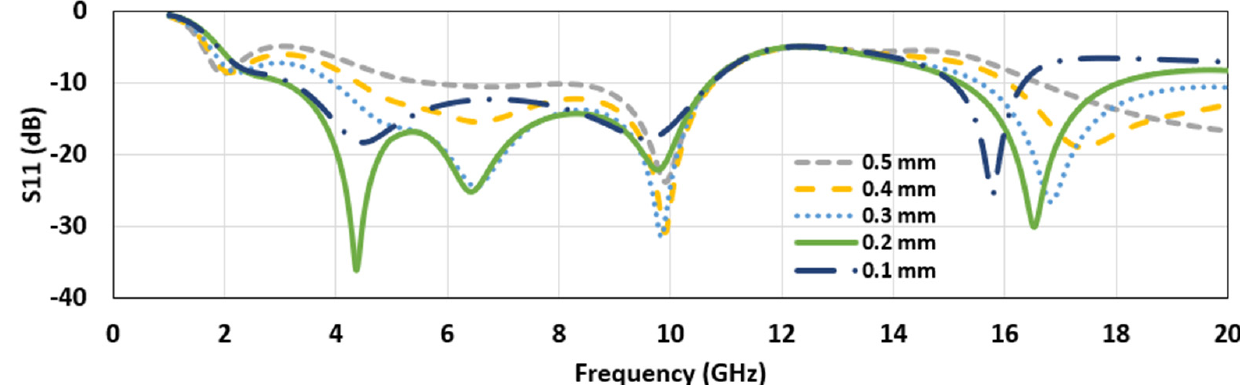
Figure 4. The reflection coefficient plot ( S 11 ) for different feedline cut depths ( C x ) (cut length, C y = 11.44 mm). From the parametric studies, it appeared that the tuning of the side cut length C y , depth of the side cut C x , and the width of the feedline strip, W f , generated a wider bandwidth. Such an observation can be justified from the current distribution plot (Figure 5) of the antenna at the three resonant frequency points of 4.6 GHz, 5.75 GHz, and 10.5 GHz. The maximum current density appeared to be concentrated at the feedline and feeding neck antenna, indicating that the tuning of the parameters C y , C x , and W f generates a wider impedance bandwidth.